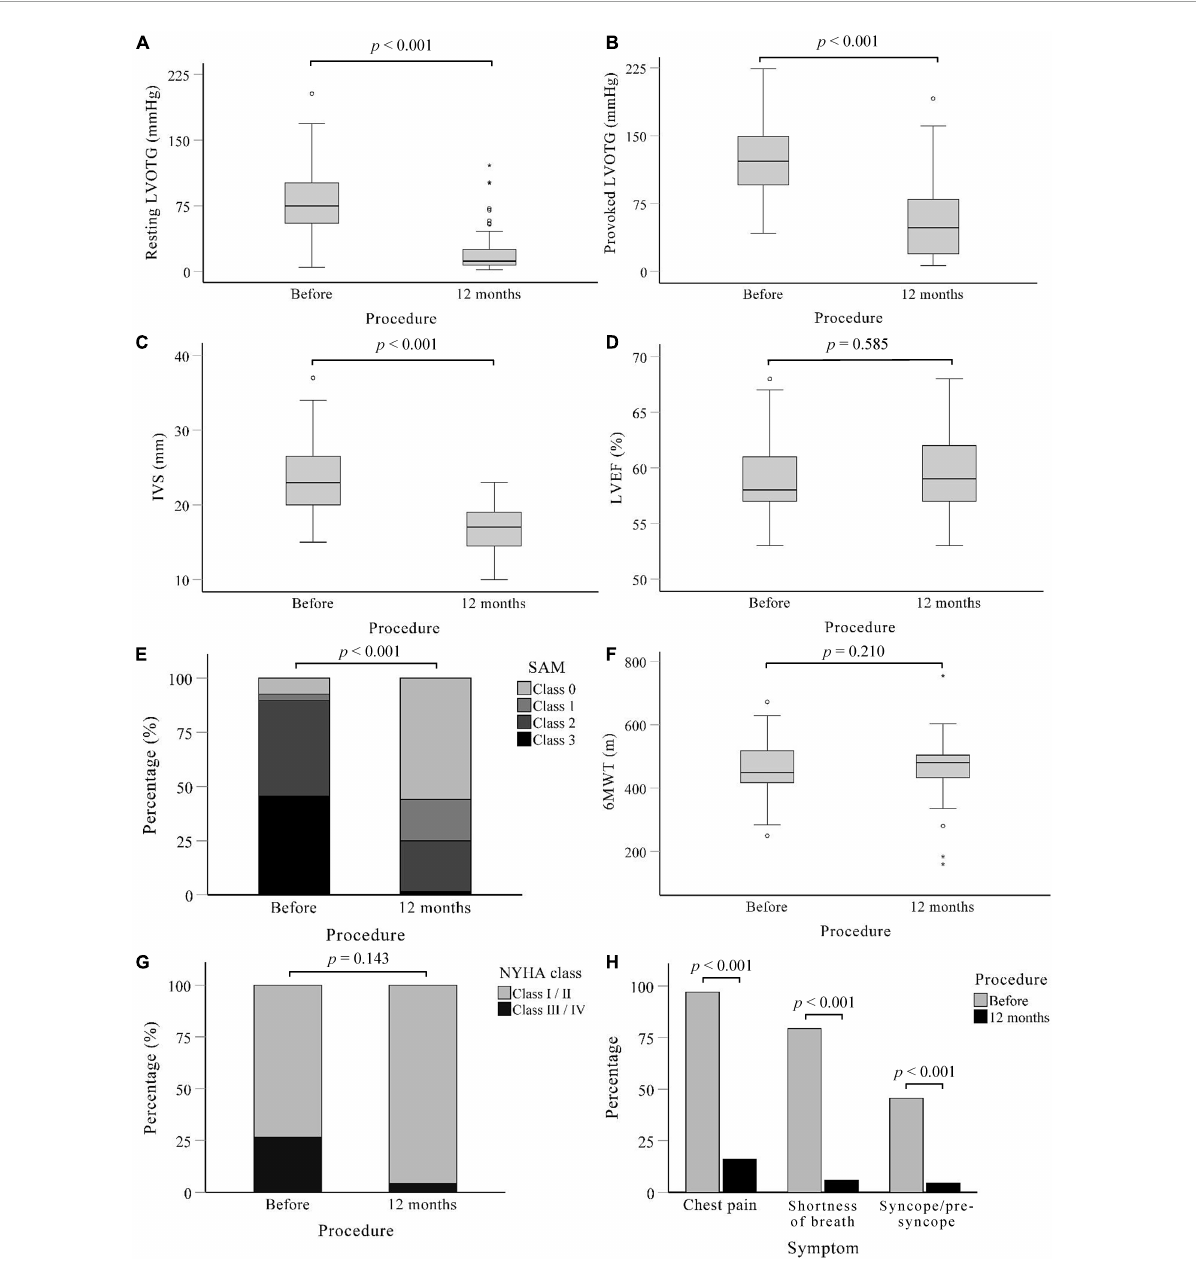
FIGURE2 Post-procedure characteristics of patients. A systematic evaluation at 12 months after procedure showed that Liwen RF TM was effective in relieving outflow tract obstruction and symptoms compared to baseline. (A) Left ventricular outflow tract gradient under calm state. (B) Left ventricular outflow tract gradient under provocation of treadmill motion. (C–E) Measured in calm state. (C) Maximum thickness of interventricular septum. (D) Change in left ventricular ejection fractions. (E) Grades of mitral valve systolic anterior motion. (F) Results of the 6-min walk test. (G) The distribution of NYHA function class among patients. (H) Incidence of the three main symptoms of chest pain, shortness of breath, and syncope/pre-syncope. IVS, Interventricular septum; LVEF, Left ventricular outflow tract; LVOTG, Left ventricular outflow tract gradient; NYHA, New York heart association; SAM, systolic anterior motion; 6MWT, 6-min walk